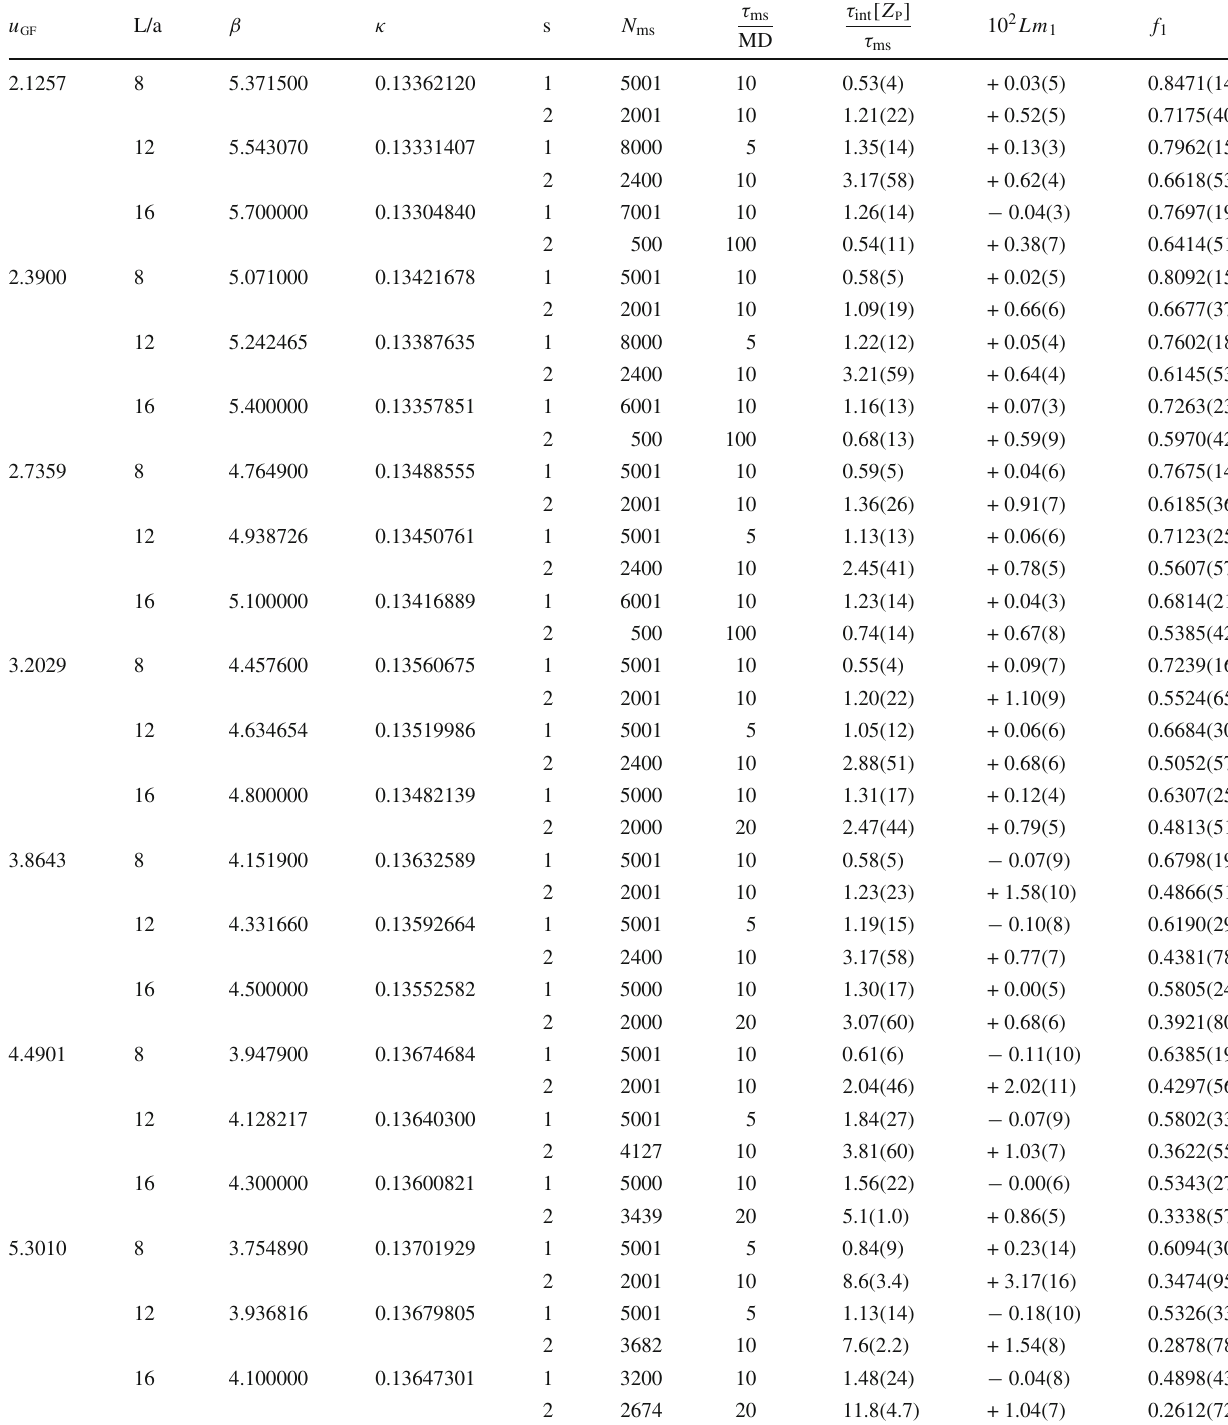
Table 10 Details for SF simulations of ( s × L / a ) 4 lattices with vanishing background field and tree-level Symanzik improved gauge action, cf. Sect. 4. Lines of constant physics (fixed u GF ) are set as reported in Ref.